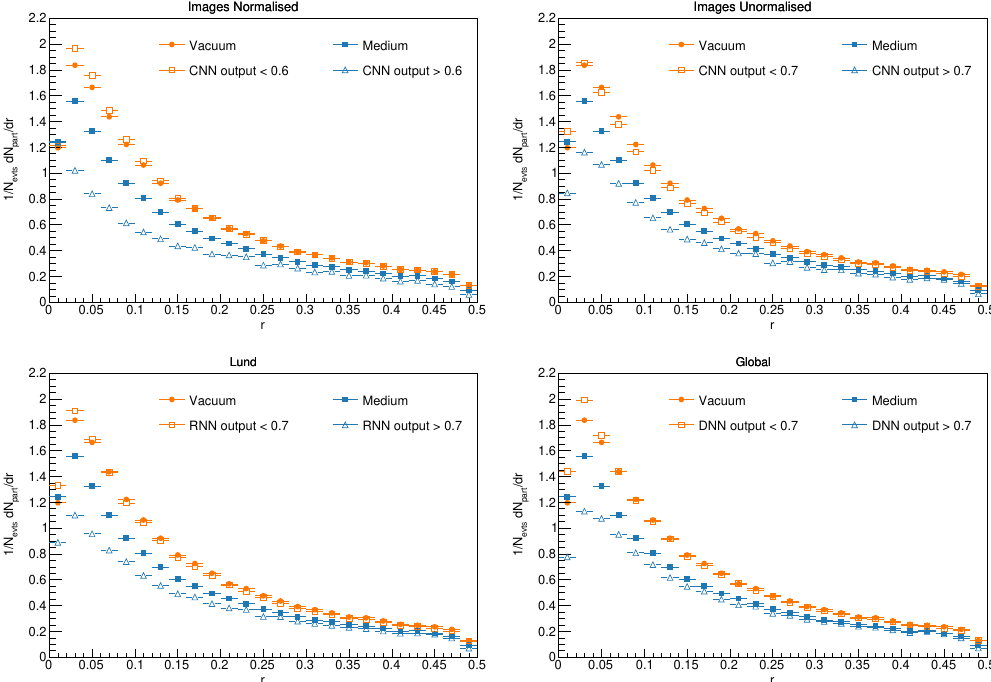
Figure 14 . Reconstructed jet radial profile (average number of constituents) r , for the different Deep Learning architectures. Monte Carlo truth from JEWEL+PYTHIA is provided in solid symbols for the Vacuum and Medium samples and a subset of events selected by the DL discriminant appears in open symbols. The DL output selection employed to identify vacuum-like jets (open blue) and medium-like jets (open orange) is made explicit in the legend of each